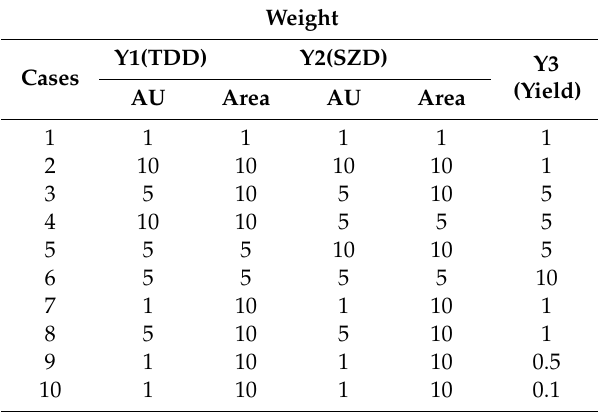
Table 5. Optimization scenario based on weight by